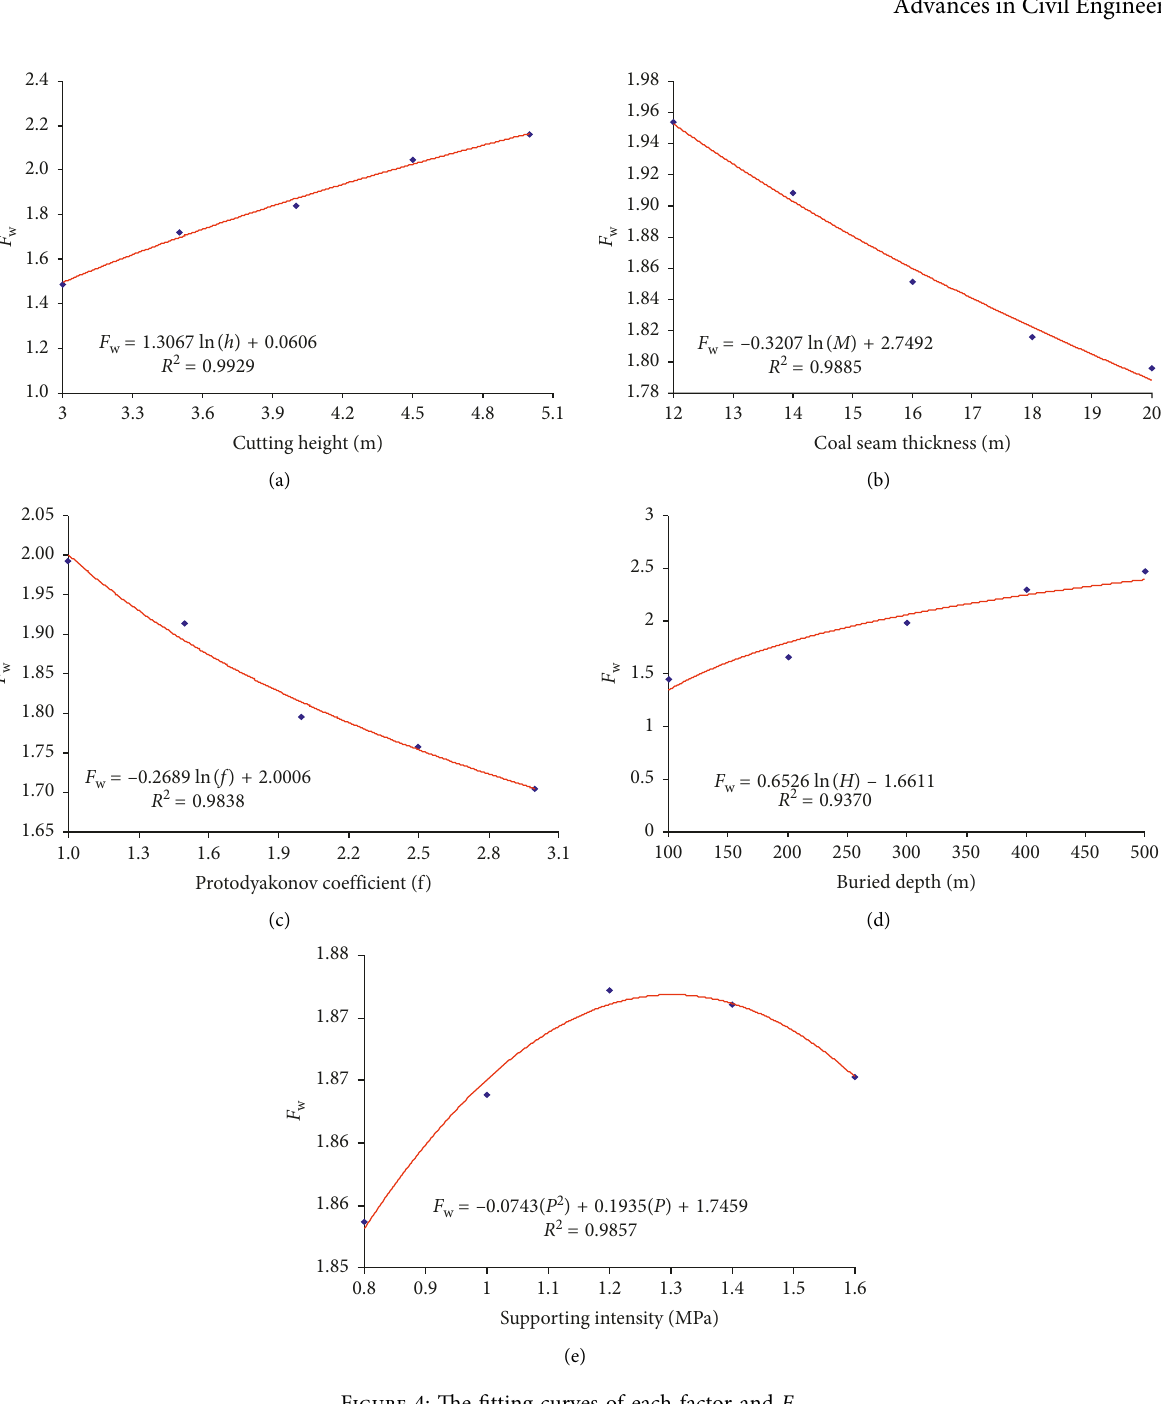
Figure 4: The fitting curves of each factor and F